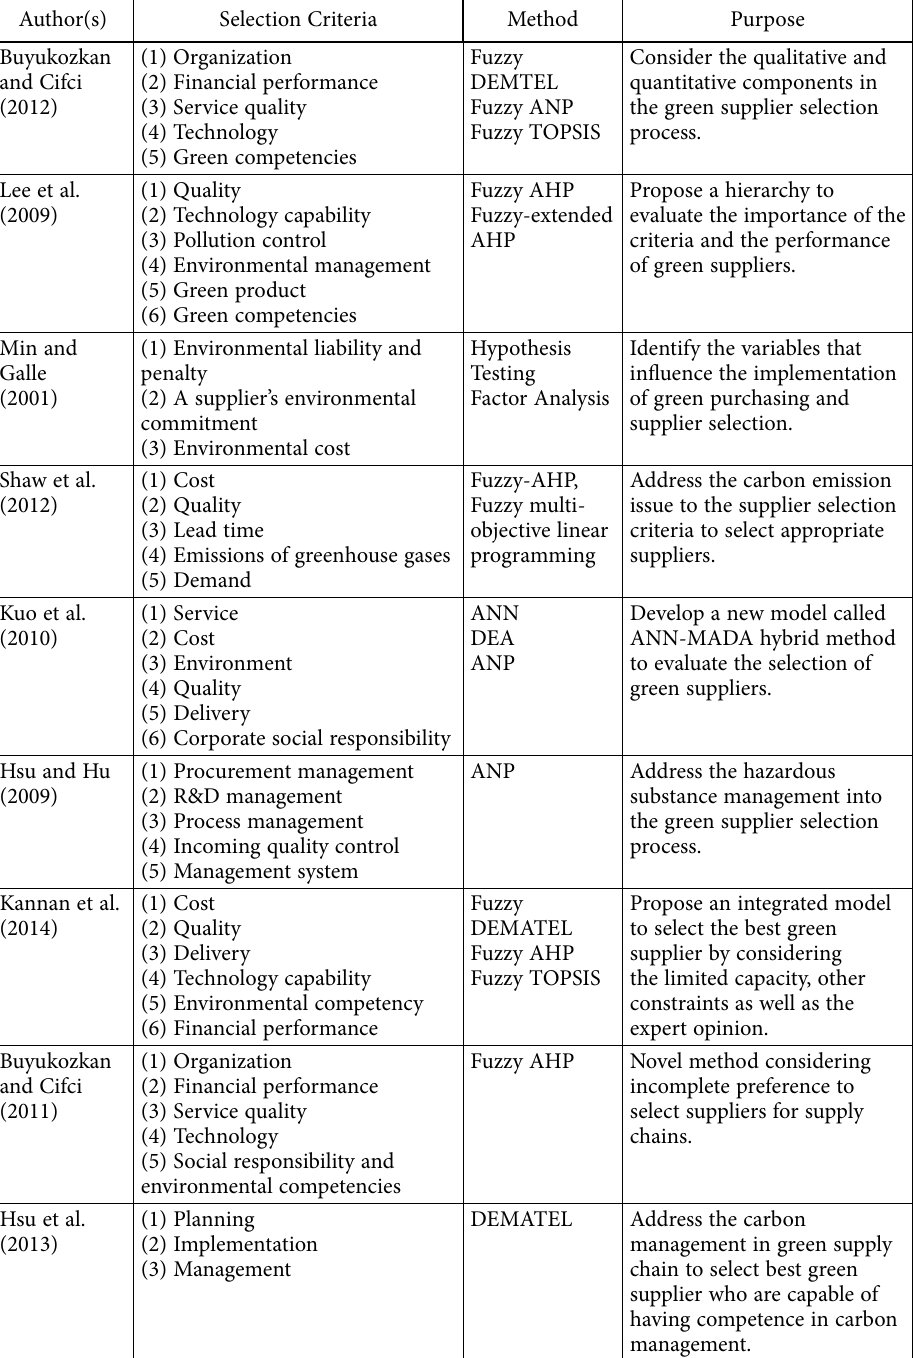
Table 1. The top ten cited articles in green supplier selection in 2019 Author(s) Selection Criteria Method Purpose